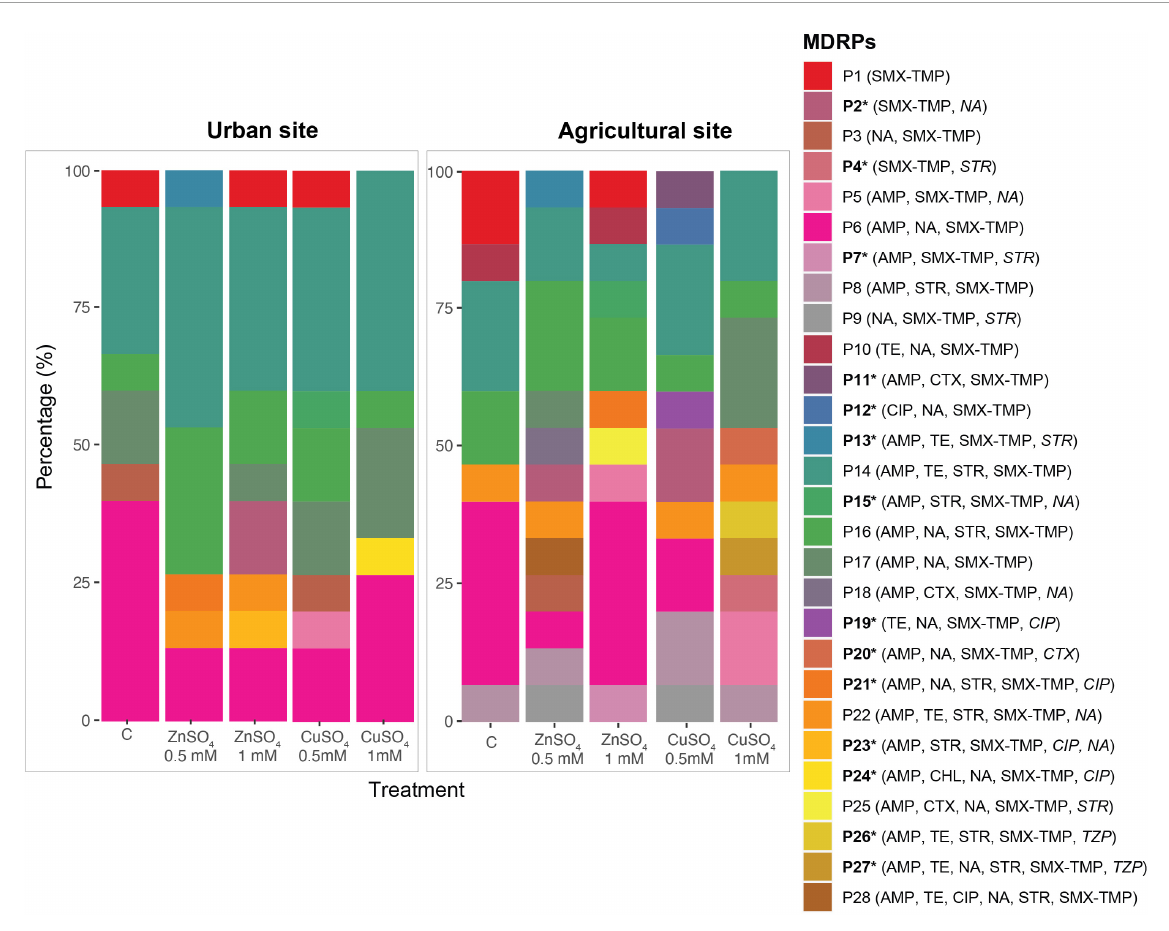
FIGURE4 Distribution and abundance of MDRPs obtained from conjugation experiments in the absence (C) and presence of ZnSO 4 and CuSO 4 at 0.5 and 1 mM. Urban and agricultural areas in the La Paz River basin were used as the source of bacterial donor communities. A total of 28 MDRPs (P1–P28) were identified in 150 randomly selected transconjugants analyzed by the Kirby-Bauer Disk Diffusion Susceptibility Test to 13 antibiotics. Each identified profile was labeled with a distinctive color followed by the antibiotic resistance profile. Antibiotics whose transconjugants exhibited intermediate resistance are written in italics. Unique MDRPs per site are marked with a star (*), and they were only found with the addition of metals in conjugation